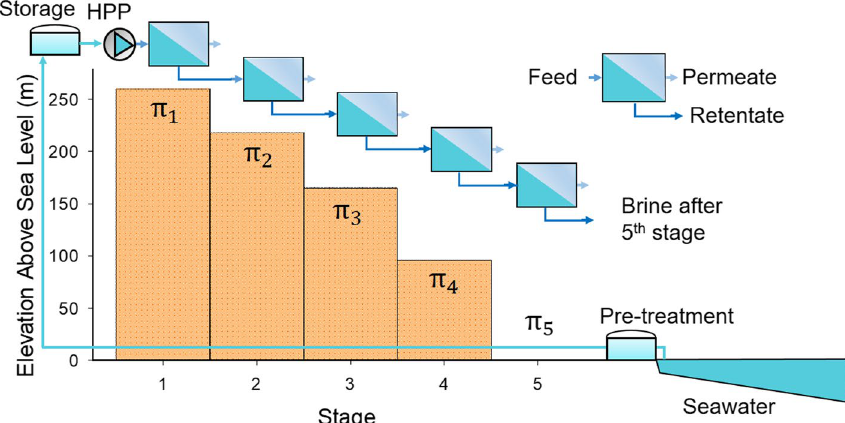
five-stage distributed gravity- assisted RO stages located on different elevations that cor- respond to demand sites. This distributed RO can be imple- mented at a location such as